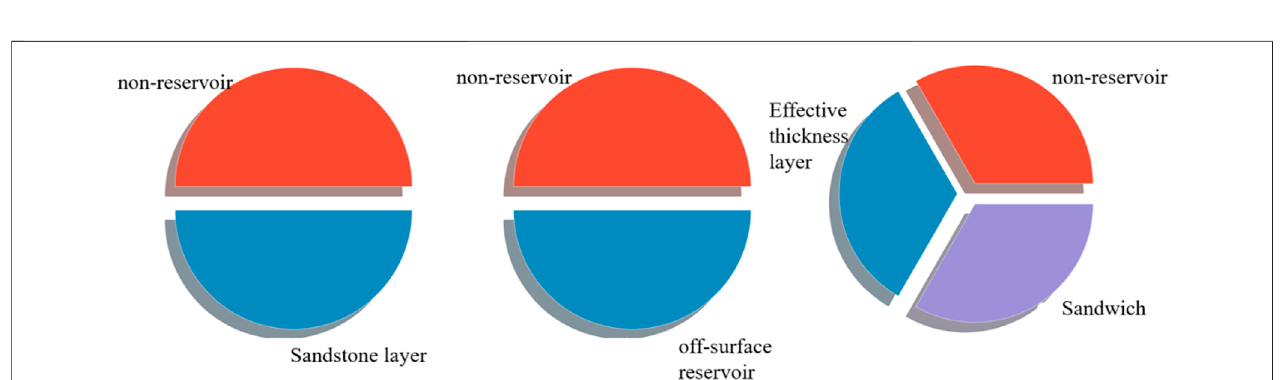
FIGURE 3 | Distribution ratio of the sandstone and reservoir in original data.